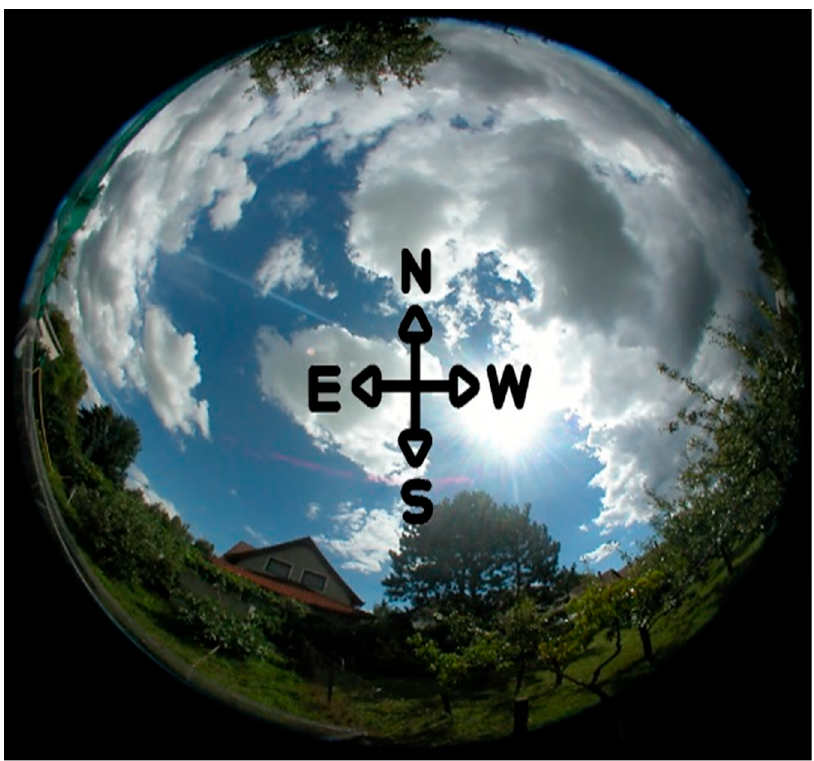
Figure 4. Fisheye view of the measuring station surroundings in the summer afternoon.